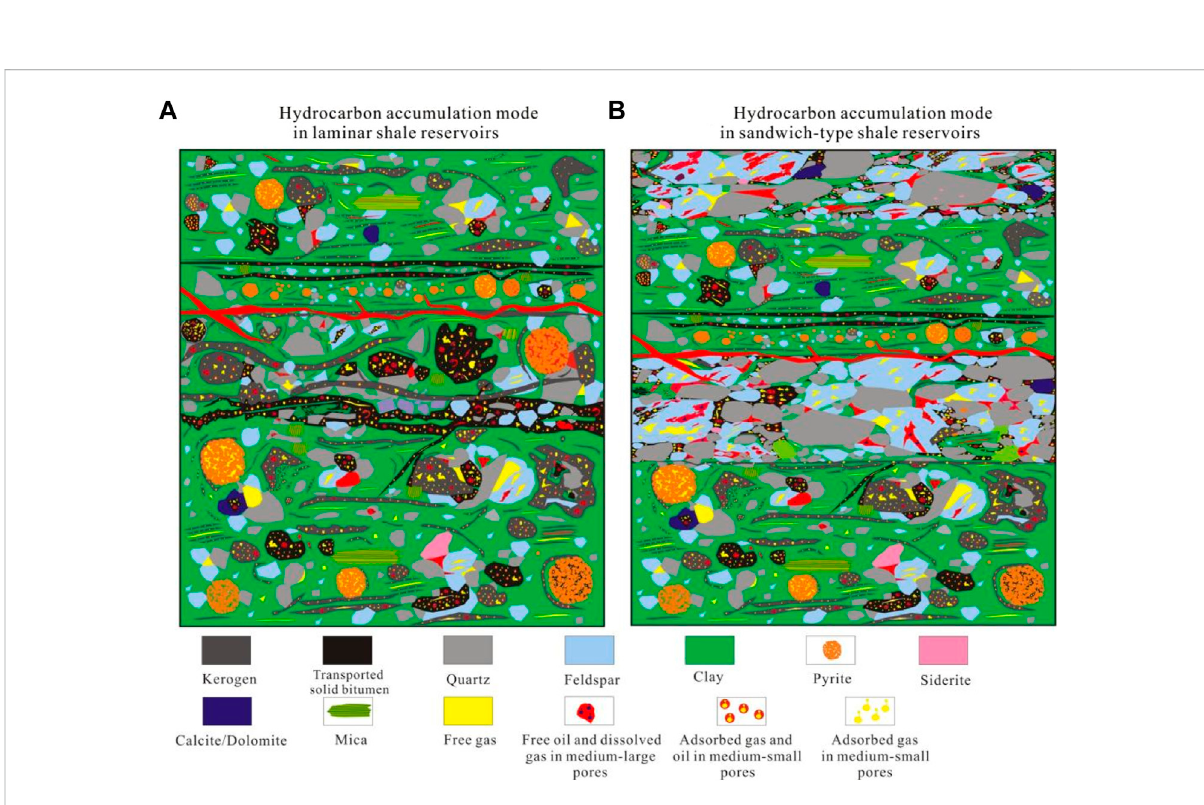
FIGURE 12 Accumulation patterns of hydrocarbons in lacustrine shale. (A) Hydrocarbon accumulation pattern of laminar shale gas reservoirs; (B) Hydrocarbon accumulation pattern in sandwich-type shale gas reservoirs.